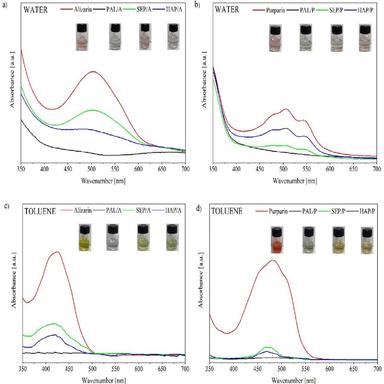
UV–vis spectra of the pure natural chromophores and hybrid pigments in water and toluene.